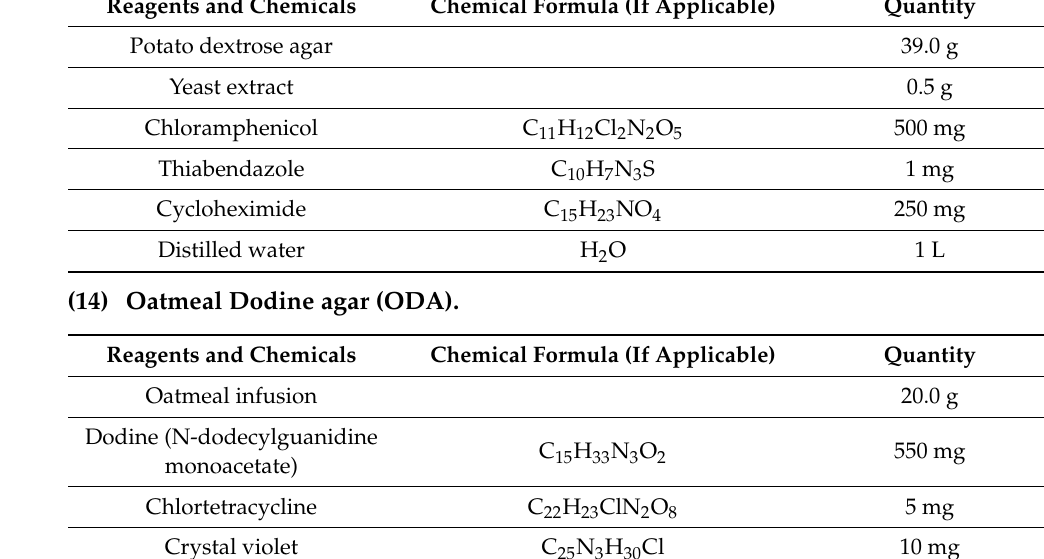
(13) Chloramphenicol Thiabendazole Cycloheximide (CTC) medium. Reagents and Chemicals